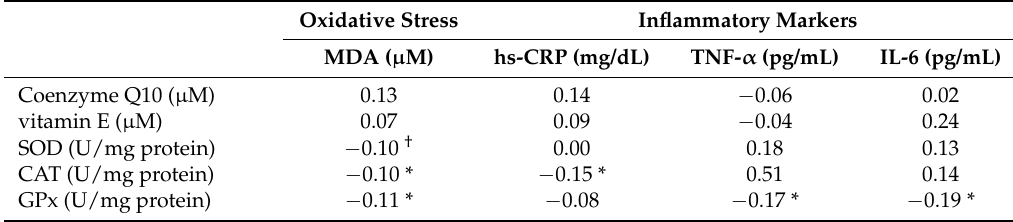
Table 3. Correlations 1 between coenzyme Q10, oxidative stress, and inflammation in HCC patients. Oxidative Stress